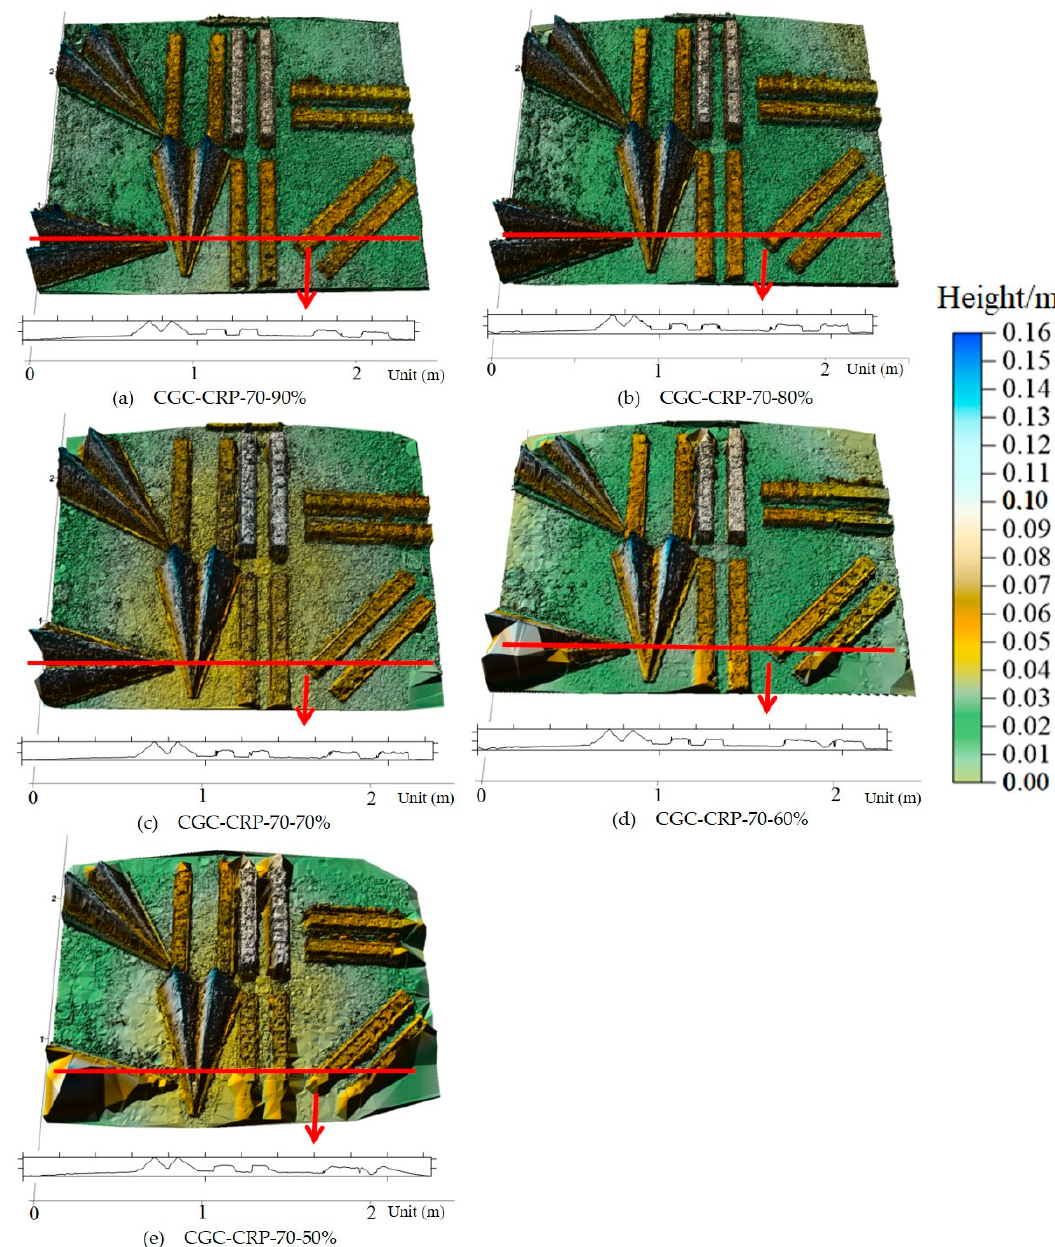
Figure 6. Maps generated from DEMs obtained using the CGC-CRP method with different image overlapping rate settings, ( a ) 90%, ( b ) 80%, ( c ) 70%, ( d ) 60%, and ( e ) 50%, with a shooting angle of 70°. An example transect extracted from each DEM was shown at the bottom of the map.